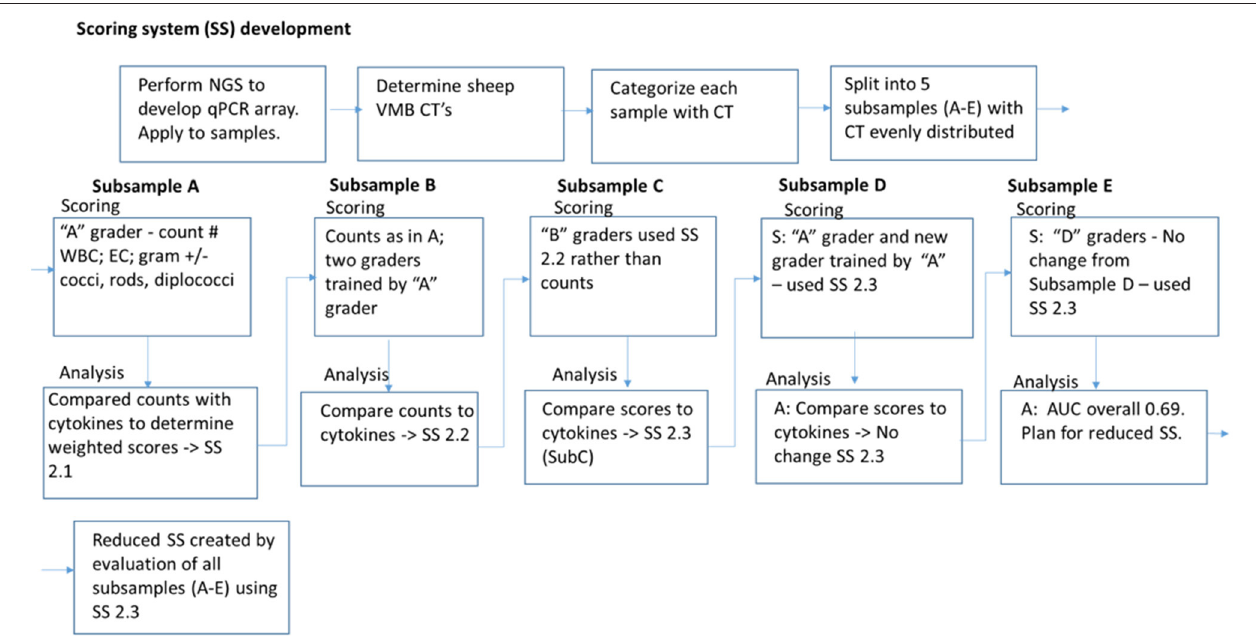
FIGURE 4 | Iterative development of Gram stain slide scoring system. Vaginal microbiomes for each sample were determined by next generation sequencing (NGS) and quantitated PCR (qPCR), were categorized into community types (CT). Gram-stained slide images were split into five subsamples (A–E) with equivalent distribution of CTs. A scoring system (SS) was created based on counting the white blood cells (WBC), epithelial cells (EC), and Gram staining and morphotypes of bacteria, and applied to Subsample A. The counts were compared with cytokine-based inflamed categorization for weighting and modification of the SS. The modified SS was utilized for scoring Subsample B, and a similar process of comparison to inflammation, weighting, and modification was applied for each subsequent Subsample. After all the subsamples were analyzed with the modified SS used for Subsample E, and noted to have area under the curve (AUC) 0.69, the SS was simplified and reduced with removal of the conflicting parameters. The final reduced SS had AUC